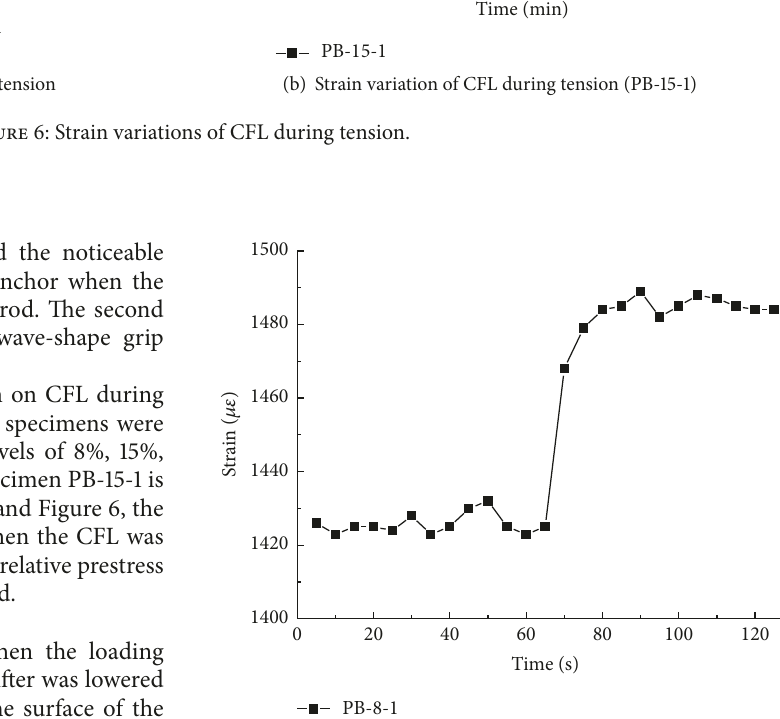
Figure 7: Strain variation of CFL during